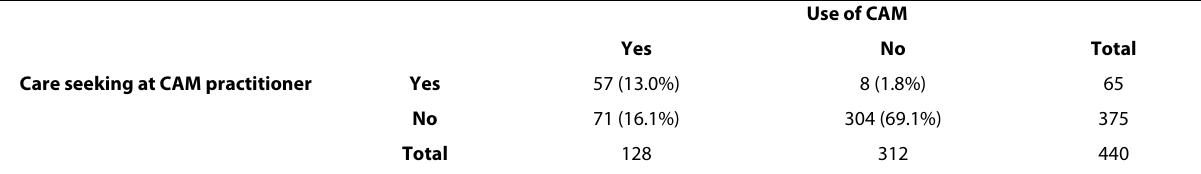
Use of CAM Yes No Total